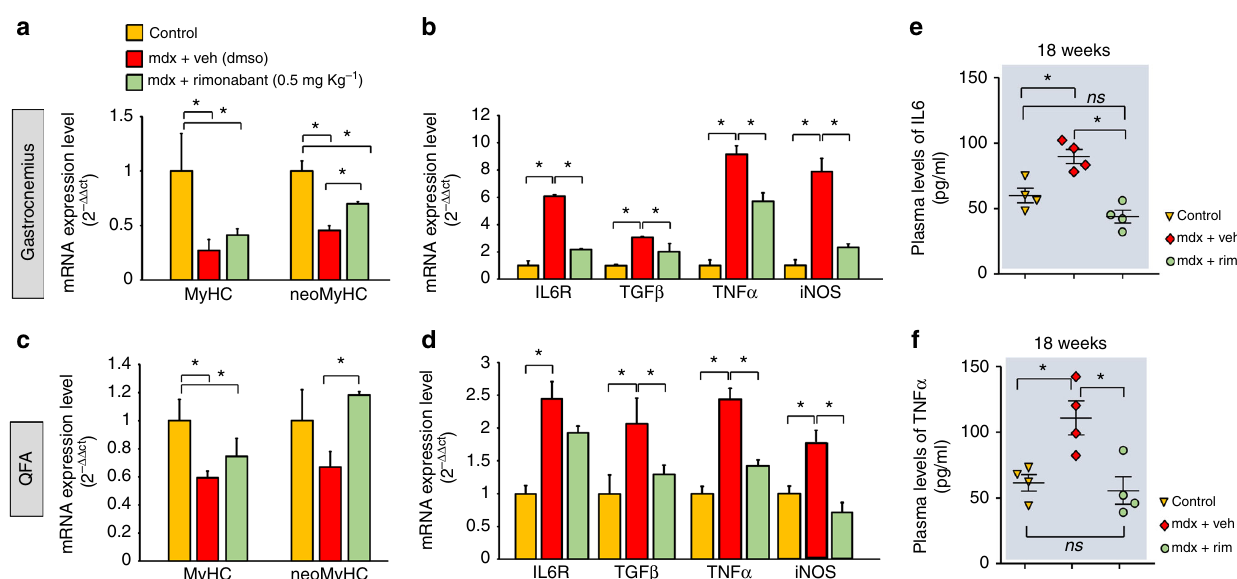
Fig. 8 Effect of rimonabant on the expression of in fl ammation markers. The bar graph shows the expression levels of myosin heavy chain (MyHC) and neonatal-myosin heavy chain (neo-MyHC) ( a and c ) and/or transforming growth factor β 1 (TGF- β 1), tumor necrosis factor α (TNF α ), interleukin receptor 6 (IL6R), and inducible nitric oxide synthase (iNOS) ( b and d ) in the indicated skeletal muscles isolated from control (dark yellow), mdx mice + vehicle (DMSO, red columns) and mdx mice + rimonabant (0.5 mg Kg − 1 , green columns). Each bar is the mean ± SEM of six separate determinations. e , f Plasma levels of IL6 and TNF α quanti fi ed by ELISA in control ( n = 4) and mdx mice treated with vehicle (DMSO; n = 4) or rimonabant 0.5 ( n = 4) mg Kg − 1 . * P ≤ 0.05 vs. vehicle group, determined by Student ’ s t test